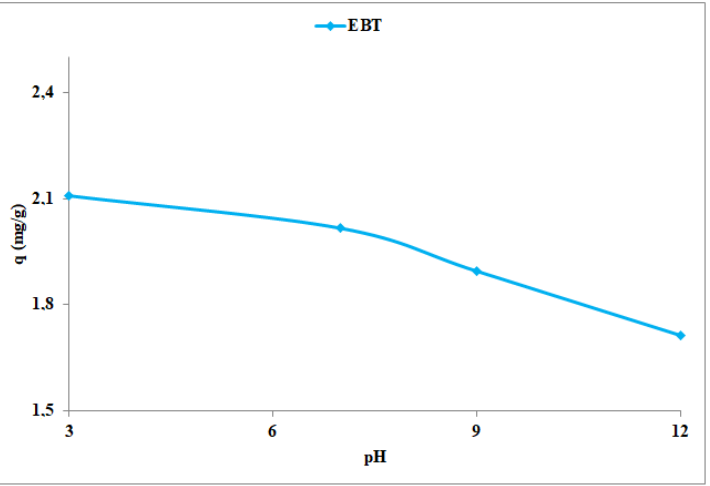
Figure 5. pH effect on the adsorption of EBT dye by activated carbon of cannabis ( t = 90 min, T = 20 − 1 ), stirring speed = 150 ± 1 °C, adsorbent dose 10 mg, (C 0 = 10 mg.L − 1 ), stirring speed = 150 rpm. T = 20 ± 1 ◦ C, adsorbent dose 10 mg, (C 0 = 10 mg.L